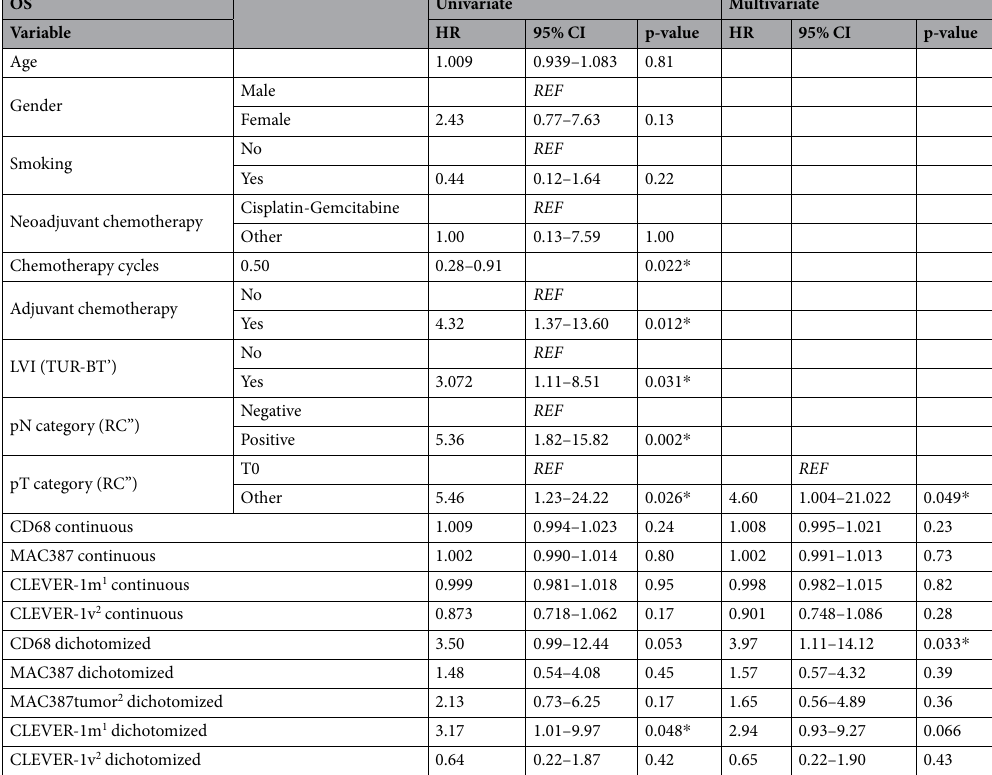
Table 4. Univariate and multivariate Cox proportional hazards regression analysis of factors affecting OS. The stage of the tumor was combined with each marker separately in multivariate analyses. ’According to the TUR-BT pathology, imaging studies and clinical status. ’’According to the pathological data from RC. 1 CLEVER-1 positive macrophages. 2 CLEVER-1 positive vessels. 3 MAC387 positive tumor cells. * Significant